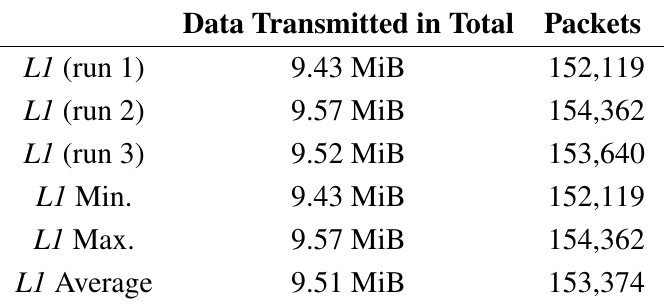
Table 4. Data transmission statistics for L1 .